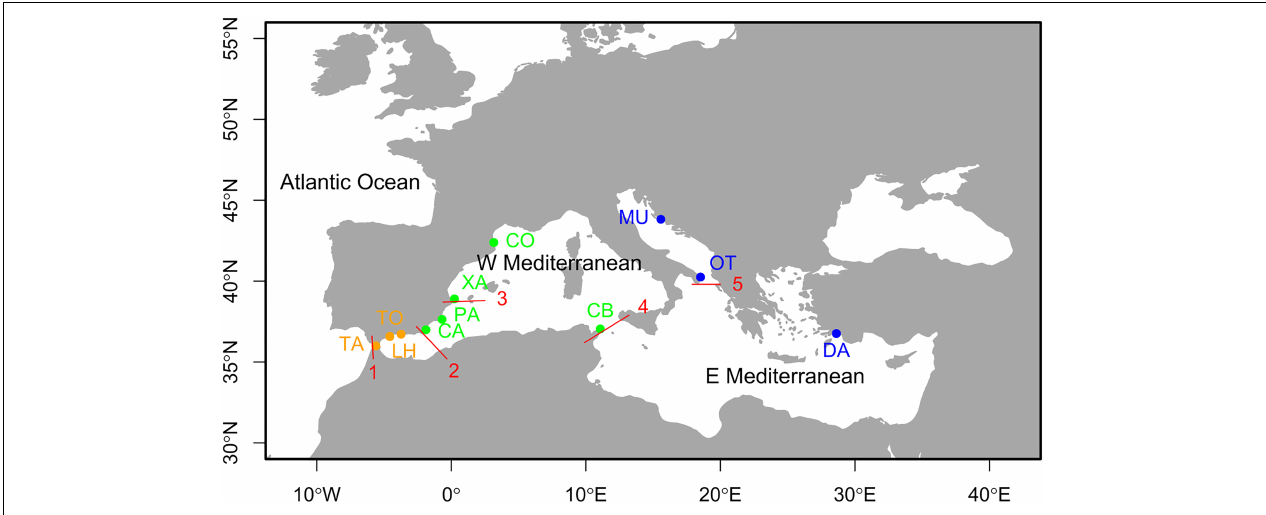
FIGURE 1 | Map of the Mediterranean Sea indicating the sampled localities, coded as in Table 1 . Color codes are: orange, transitional area (Alboran Sea, west of the Almeria-Oran front), green, western Mediterranean; blue, eastern Mediterranean. The red lines show the main oceanographic discontinuities in the area: 1, Gibraltar Strait; 2, Almería-Orán Front; 3, Ibiza Channel; 4, Sicily Channel; 5, Otranto Strait. Map generated with package rworldmap of R